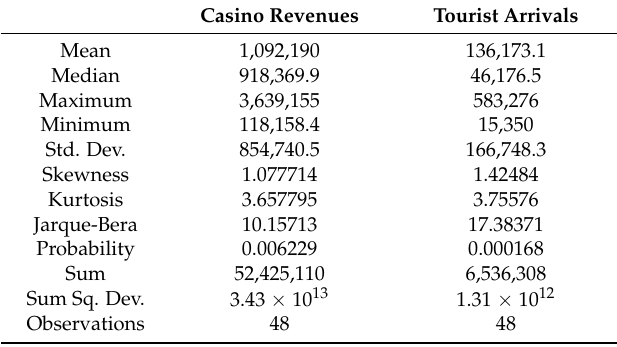
Table 2. Descriptive statistics of